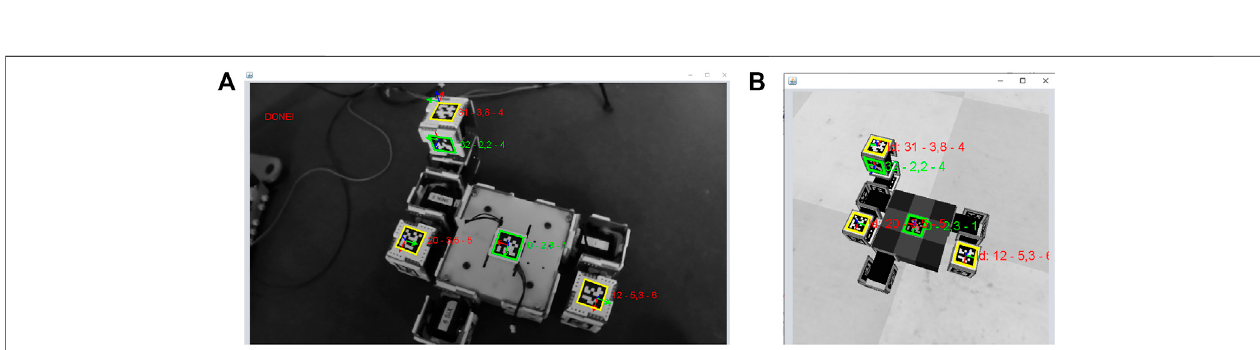
FIGURE 4 | The assembly tool when building a robot with EMERGE modules (A) The image from a handheld camera controlled by a user (B) The image from the simulation taken by a virtual camera with the same position and orientation as the handheld camera. All the recognized Apriltags are highlighted indicating if they are placed correctly (Green means “ OK ” , yellow “ double check ” and red “ not placed correctly ” ) Additionally, the id of the tag, and the distance and orientation errors are shown.